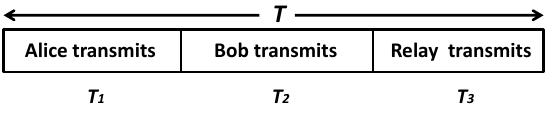
Figure 3: Time slots allocated to three legitimate nodes in our proposed scheme.